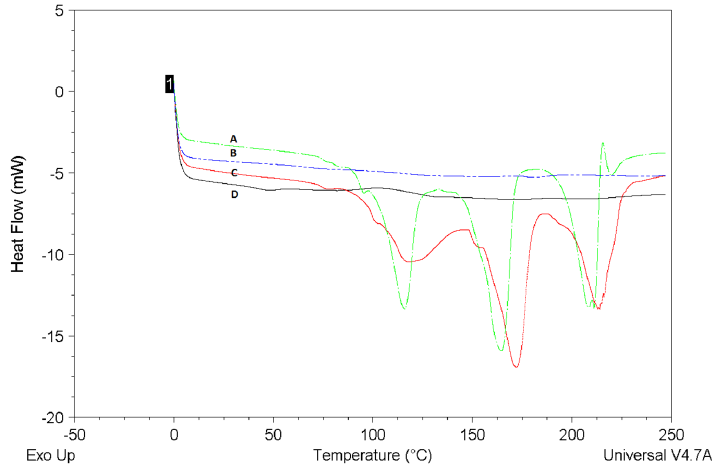
Figure 4. Differential scanning calorimetry (DSC) study. DSC endothermal curves of berberine hydrochloride (BER) ( A ), N -[8-(2-hydroxybenzoyl)amino]caprylate (SNAC)-loaded microspheres ( B ), physical mixture of BER/SNAC-loaded microspheres ( C ), and BER-SNAC-loaded microspheres ( D ).